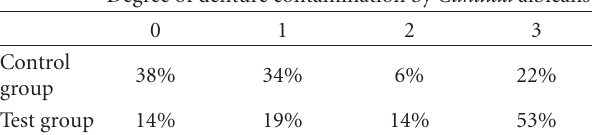
Table 3: Comparison of Candida contamination on dentures in test group and control